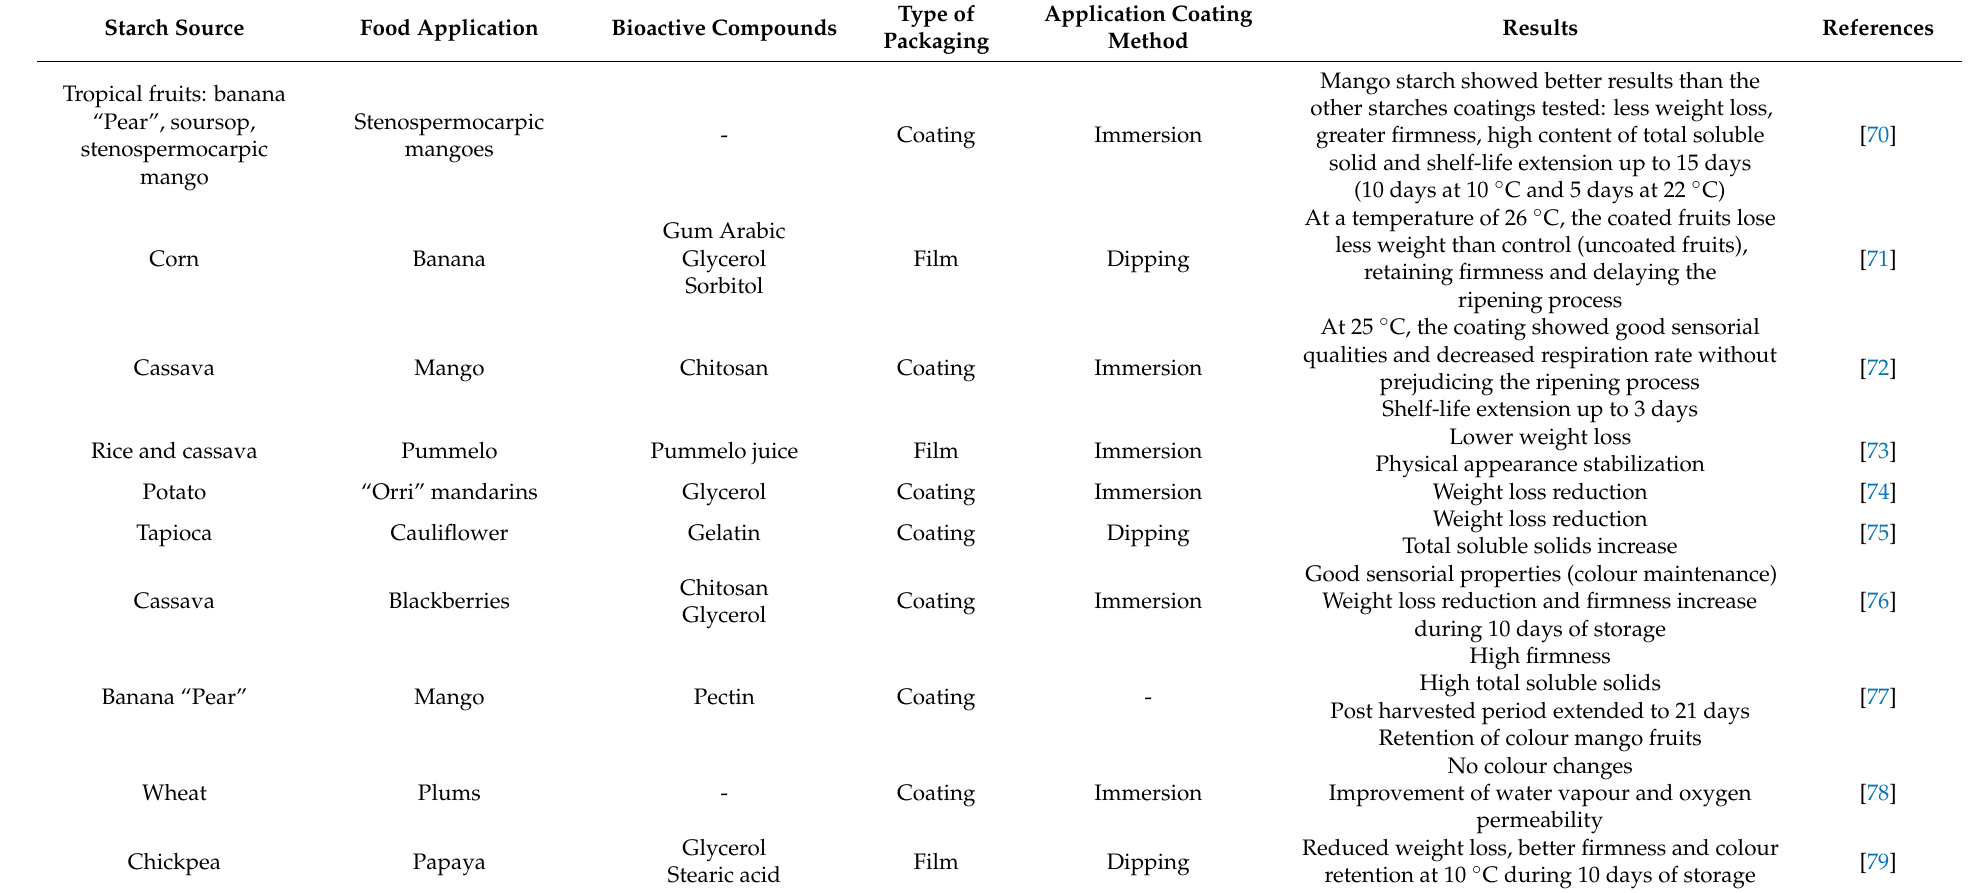
Table 2. Starch based coatings and films with or without incorporation of bioactive compounds and their properties as food